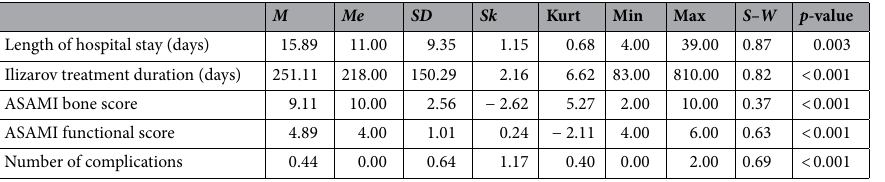
Table 1. Descriptive statistics and Shapiro–Wilk test results for quantitative variables in the patients who underwent open fixation procedures (n = 27). M mean, Me median, SD standard deviation, Sk. skewness, Kurt. , kurtosis, Min minimum, Max maximum, S–W Shapiro–Wilk test result, p-value significance of normality of distribution.